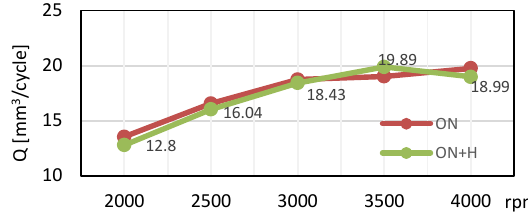
Fig. 3. Amount of injected fuel depending on the rotational speed at the supply of diesel and diesel with the addition of hydrogen